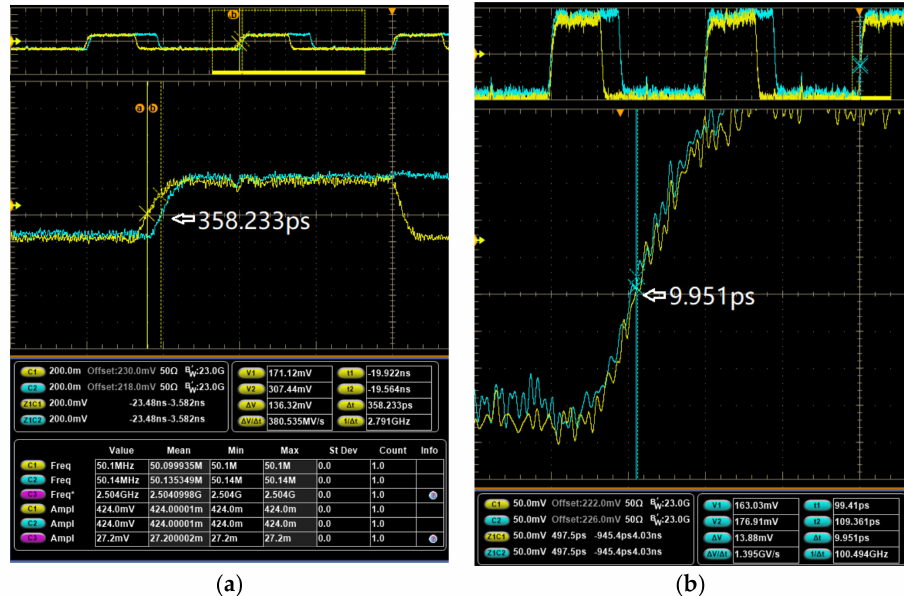
Figure 13. Test results of the static phase error ( a ) without calibration; ( b ) with calibration.